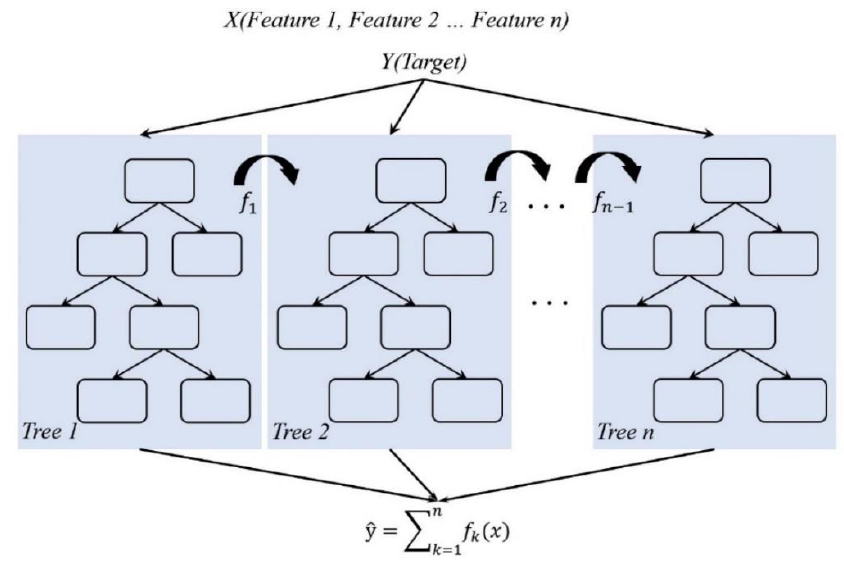
Figure 2. XGB model diagram.